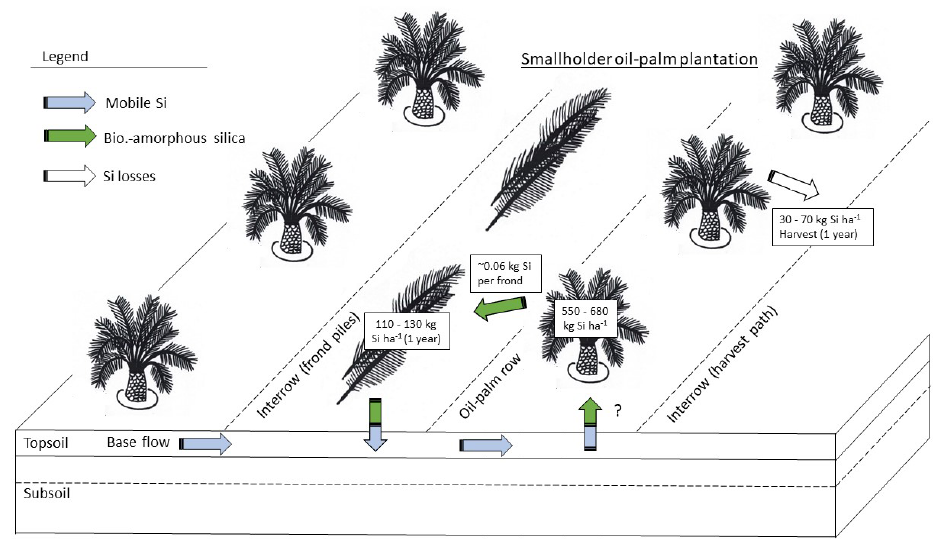
Figure 4. Si storage in the above-ground biomass of oil palms, Si return to soils through decomposing pruned palm fronds, and Si losses through harvest on smallholder oil-palm plantations in the province of Jambi, Sumatra.